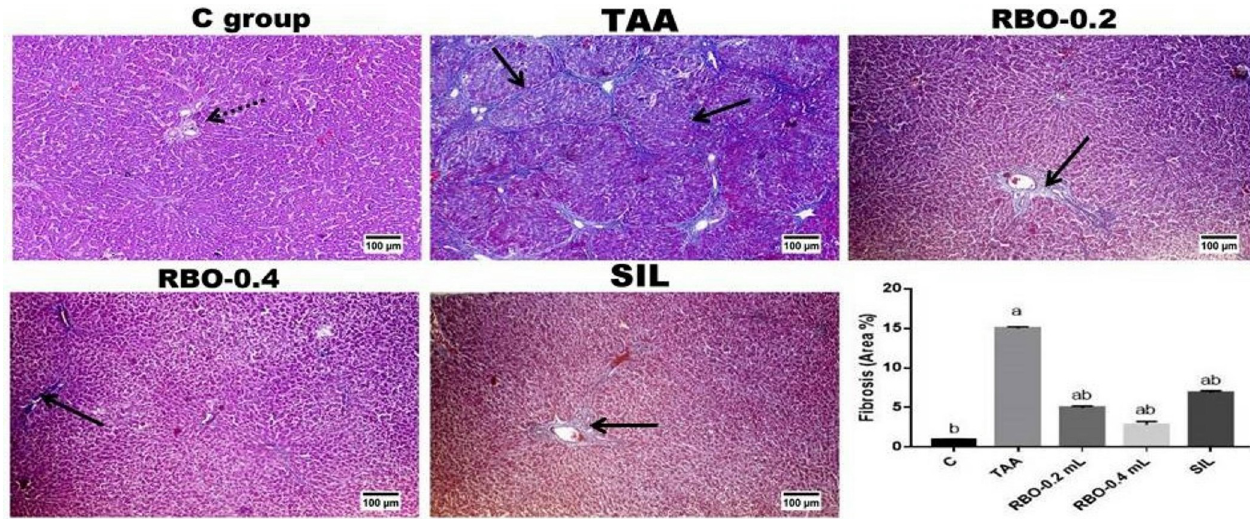
Fig 6. MTC stained liver sections. Control group showing normal limited amount of fibrous tissue in the portal areas (dotted arrow), the highest significant increase in MTC stained areas of fibrous tissue in the bridging fibrosis (arrow) in TAA group. While, RBO administration gave rise to a dose dependent significant decrease in MTC-stained areas with its limitation to portal triads (arrow) compared to TAA group and silymarin administrated group. The quantitative image analysis of the MTC stained areas presented as area percentage. All data are presented as Mean ± SEM, (n = 6). a P � 0.05 was assumed to denote statistical significance compared to the negative control, b P � 0.05 was assumed to denote statistical significance compared to TAA group. C: control; TAA: Thioacetamide; RBO: Rice bran oil.